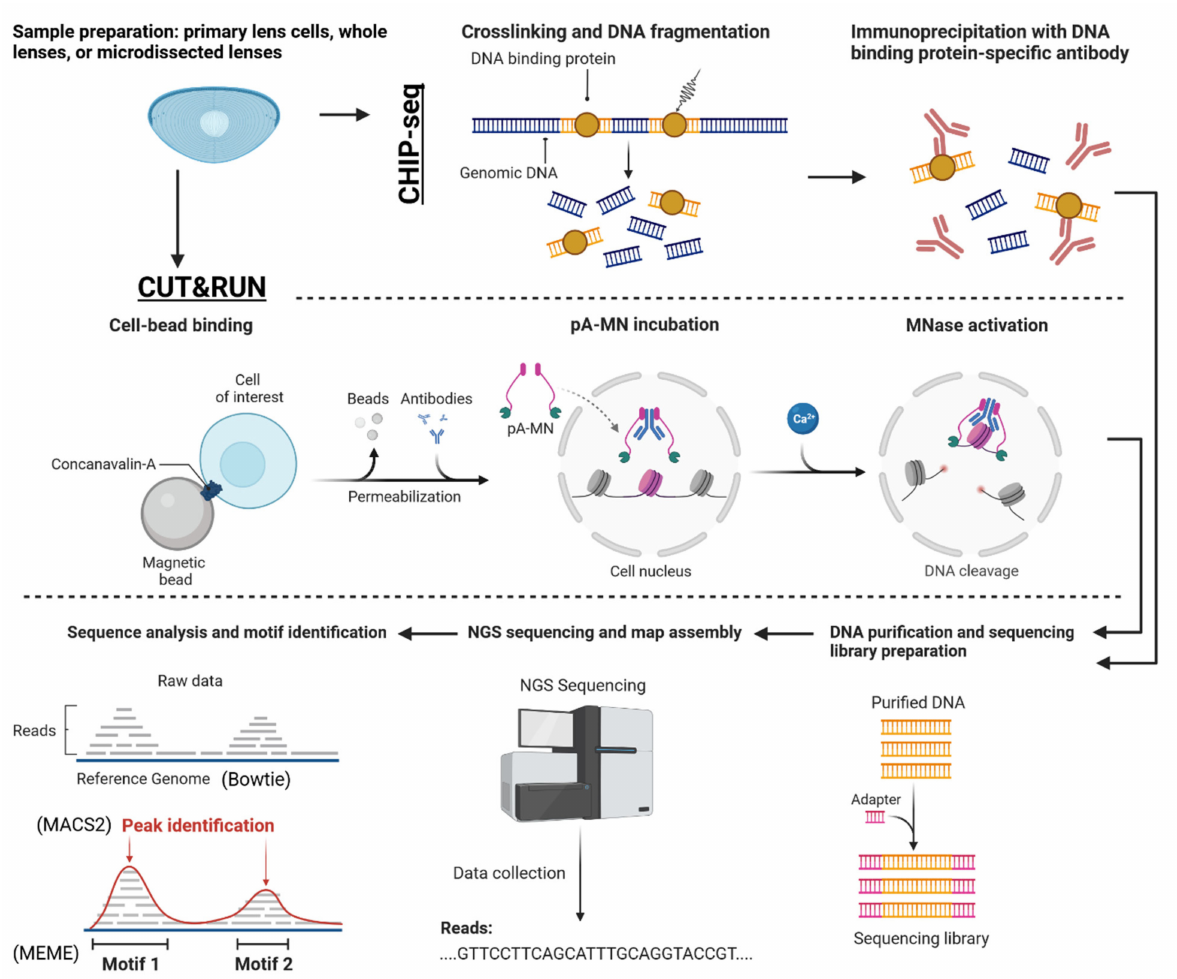
Figure 12. Workflow for a CUT&RUN/ChIP-seq experiment aiming to validate the genome-wide binding sites of a transcription factor previously identified as a candidate from a multiomics